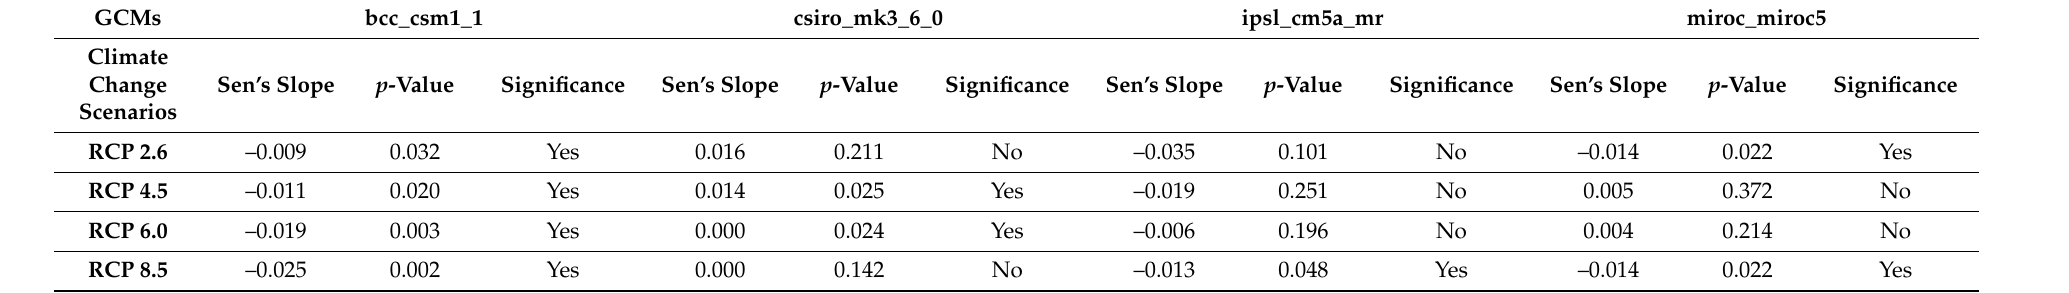
Table 4. Mann–Kendall trend test for solar radiation (2020–2059) with all the four climate change